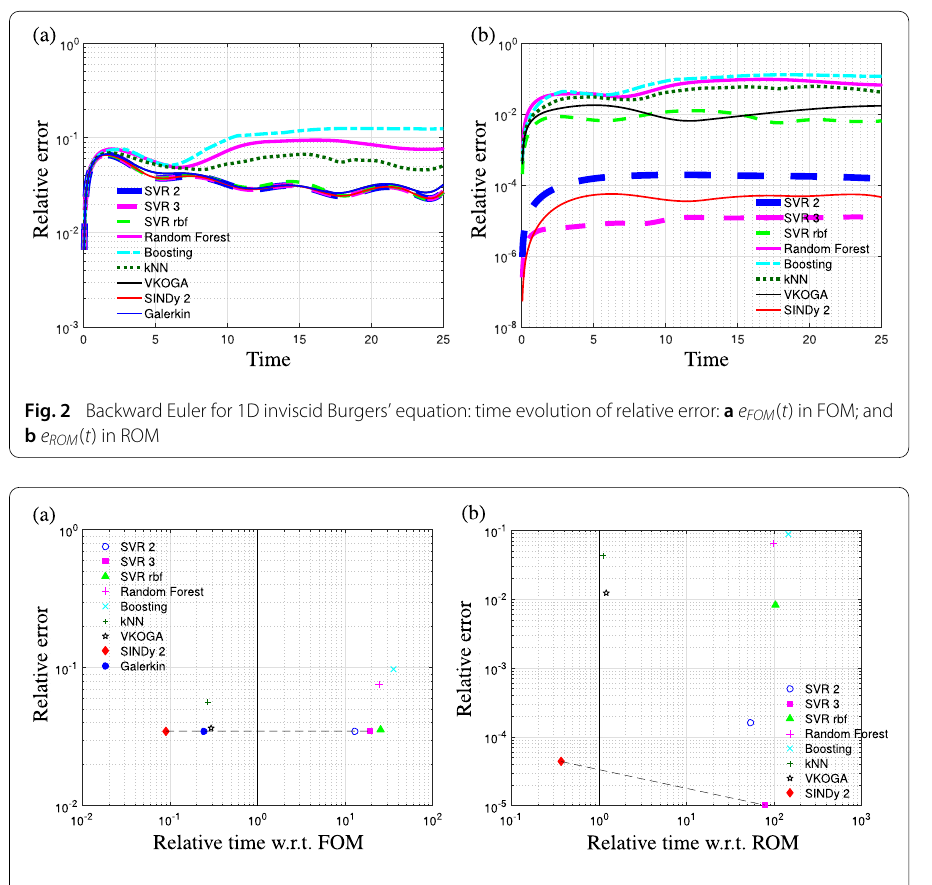
Fig. 3 Pareto frontier of relative error with respect to the relative running time using backward Euler for 1D inviscid Burgers’ equation: a e FOM vs. τ FOM in FOM; b e ROM vs. τ ROM in